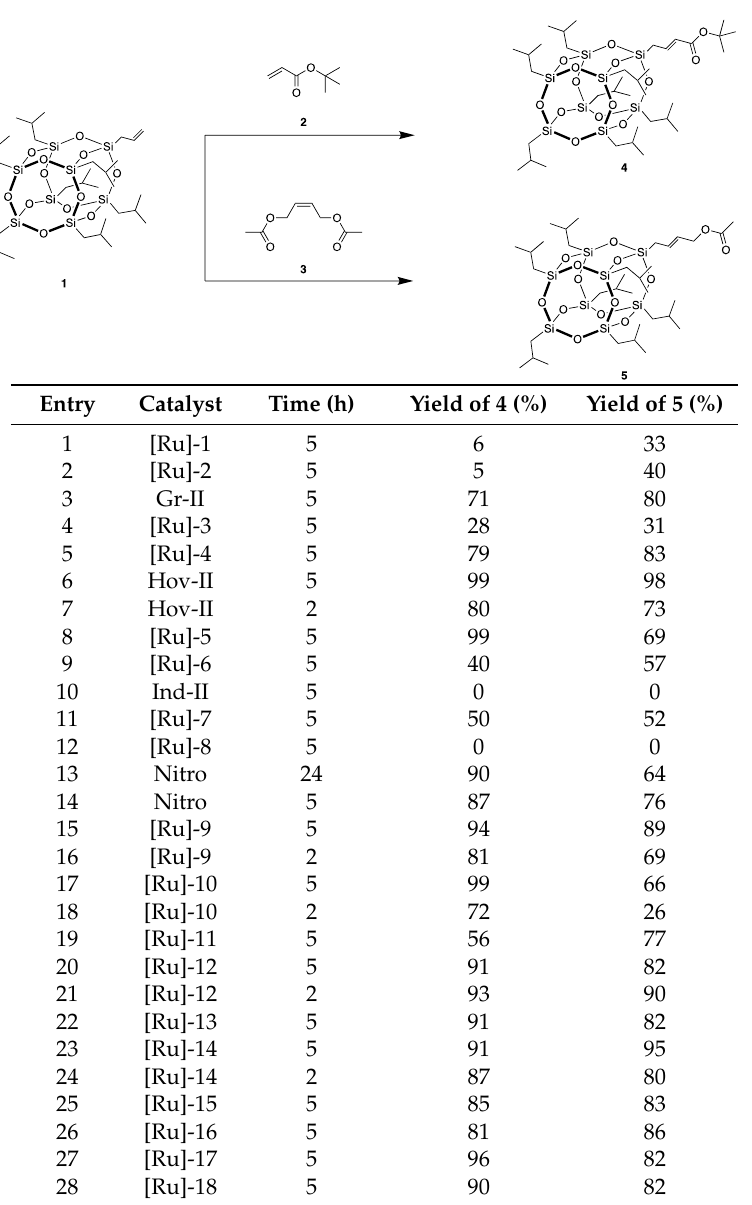
Table 1. Cross metathesis of allyl-polyhedral oligomeric silsesquioxanes (POSS) derivative with Molecules 2018 , 23 , x FOR PEER model partners.